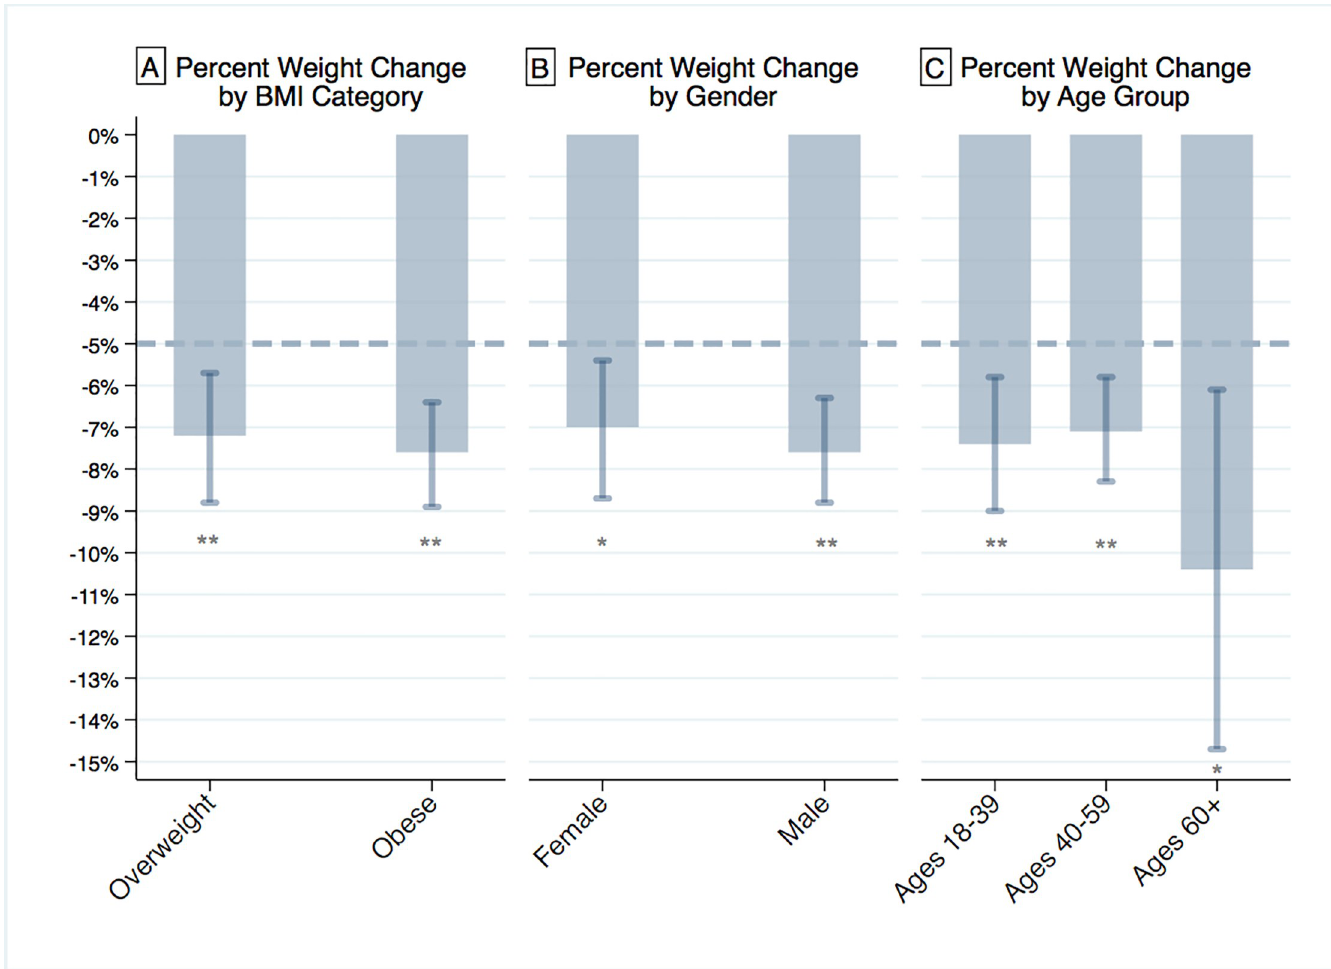
Fig 1. Twelve-month adjusted mean weight loss as a percentage of baseline body weight. A, Mean 12-month weight loss by baseline BMI category. B, Mean 12-month weight loss by gender. C, Mean 12-month weight loss by age group. Error bars represent 95% confidence intervals. � Significantly more weight loss than the 5% benchmark, P < .05. �� Significantly more weight loss than the 5% benchmark, P <